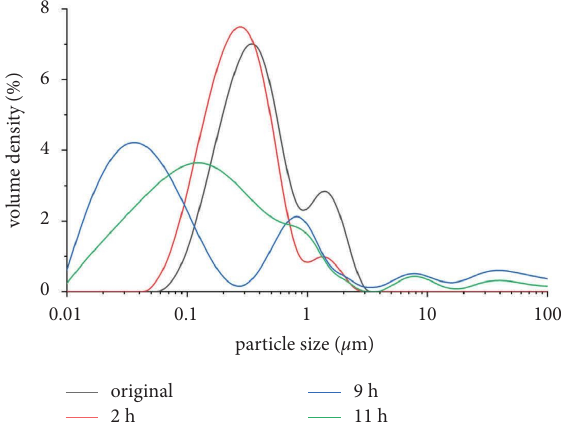
Figure 3: Dispersed orange 31 particle sizes’ distribution after grinding for 2 h, 9h, and 11h.